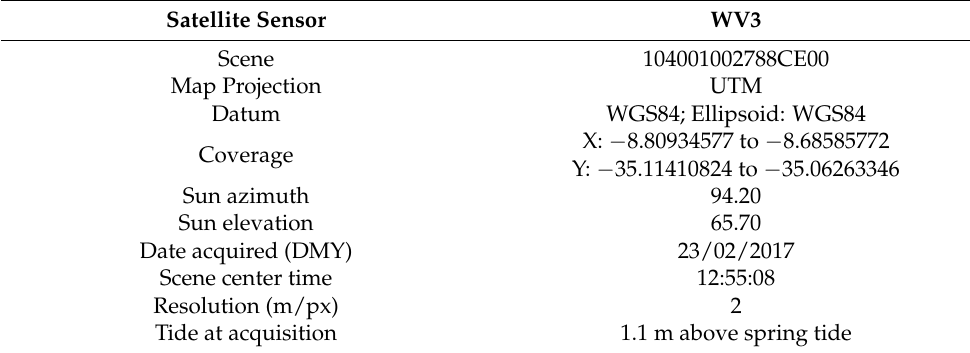
Table 1. Details of the WorldView-3 (WV3) scene used in this research for the habitat mapping provided in the metadata file. Tide at acquisition (m) was calculated based on the tide charts provided by the Brazilian Hydrographic